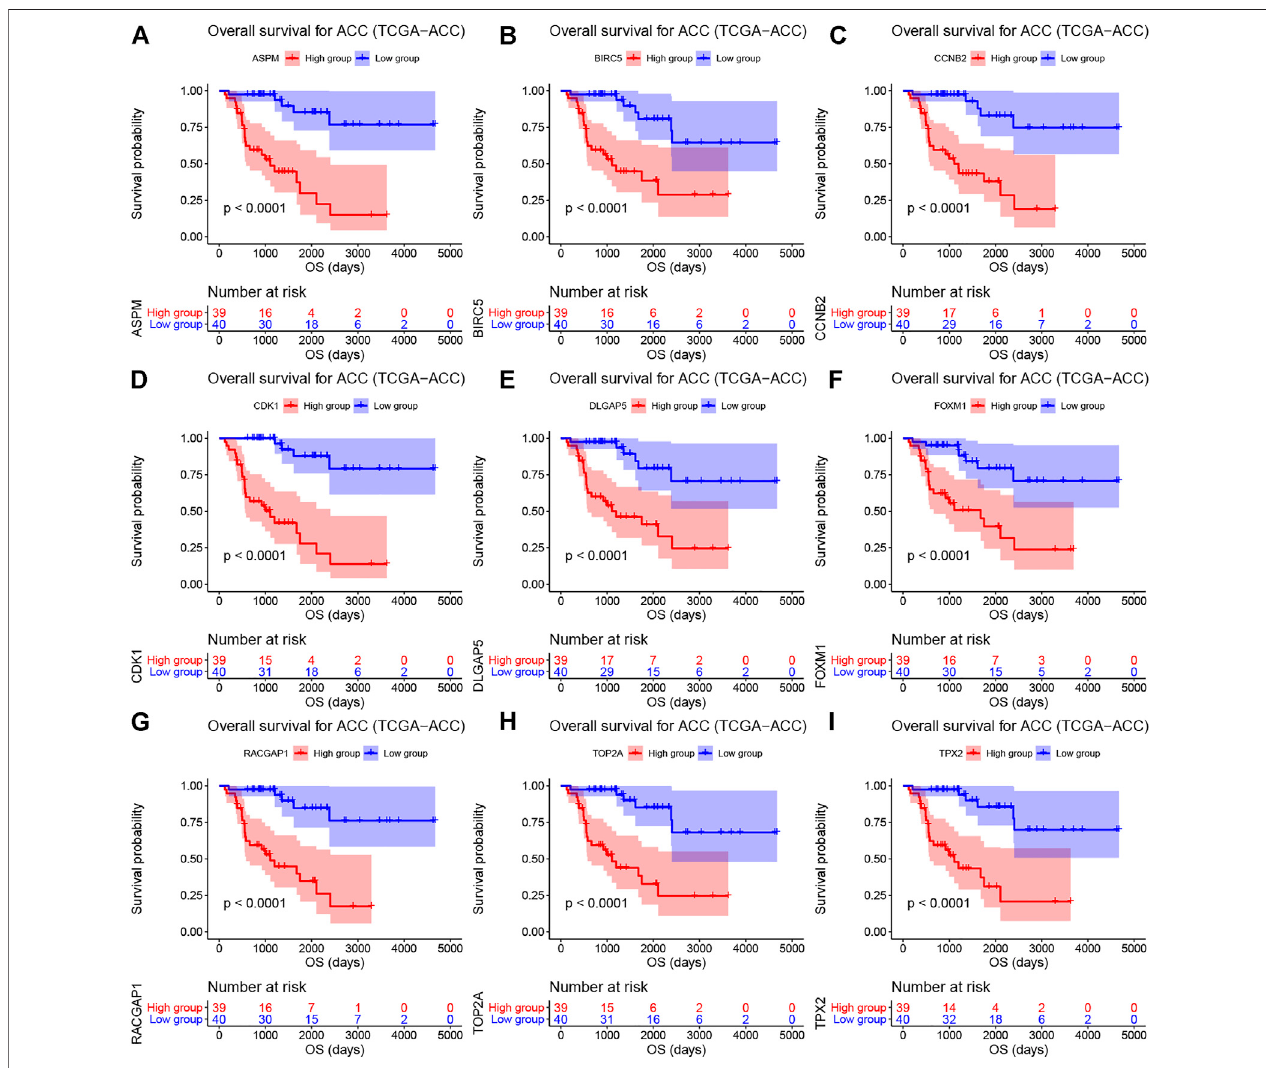
FIGURE 3 | Overall survival analyses on hub genes (ASPM (A), BIRC5 (B) , CCNB2 (C) , CDK1 (D) , DLGAP5 (E) , FOXM1 (F) , RACGAP1 (G) , TOP2A (H) , and TPX2 (I) ) based on TCGA-ACC data. Survival curves for patients in different groups. Red lines represent high expression of hub genes, while blue lines represent low expression of hub